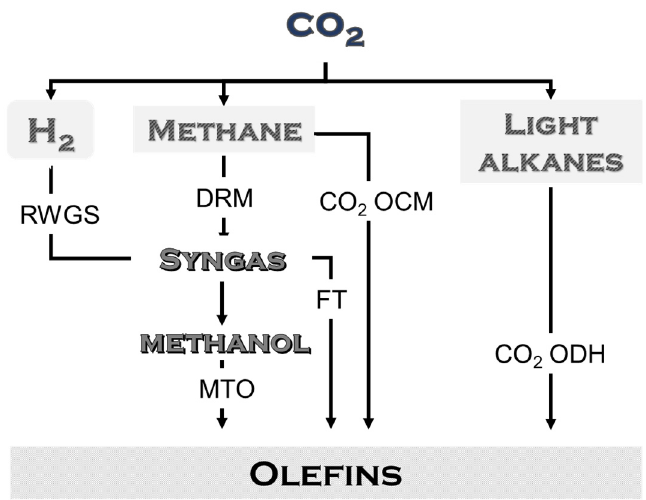
Figure 27. Schematic summary of the main technologies that can be used for production of olefins from carbon dioxide. Figure inspired by [38].